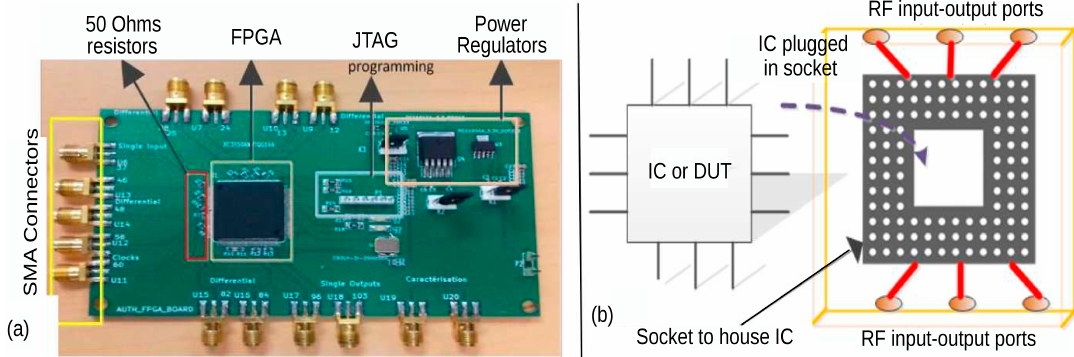
Figure 3. Device under test (DUT) setup. ( a ) A pictorial description of RF-PCB developed on FR-4 housing field-programmable gate array (FPGA) as DUT. It also highlights various axillary circuits and SMA connectors. ( b ) An illustration of using IC on a pluggable socket to be characterized with the guided RF waves.